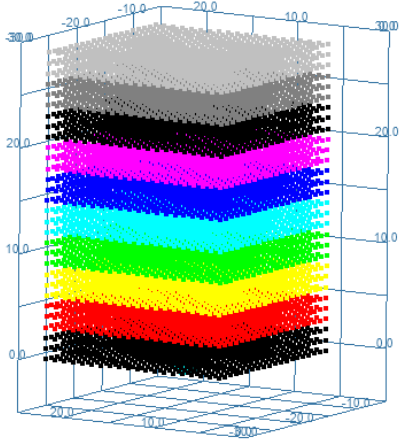
Figure 6. Discrete particle in selected mineral-rock heap.